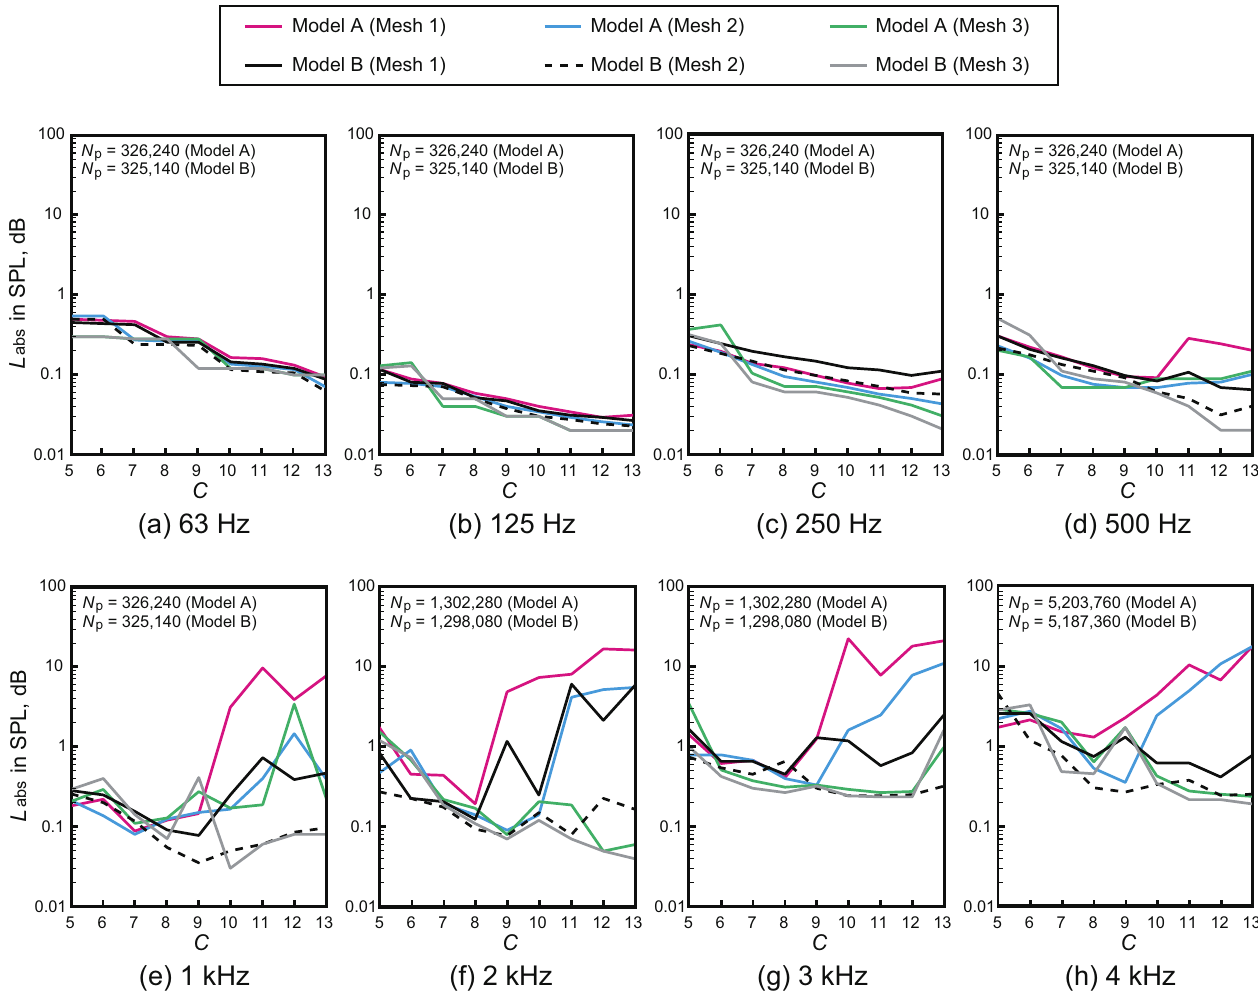
Figure 7. Comparisons of the absolute errors at eight frequencies as a function of C for Model A and Model B with three meshes, Mesh 1–Mesh 3: ( a ) 63 Hz, ( b ) 125 Hz, ( c ) 250 Hz, ( d ) 500 Hz, ( e ) 1 kHz, ( f ) 2 kHz, ( g ) 3 kHz, and ( h ) 4